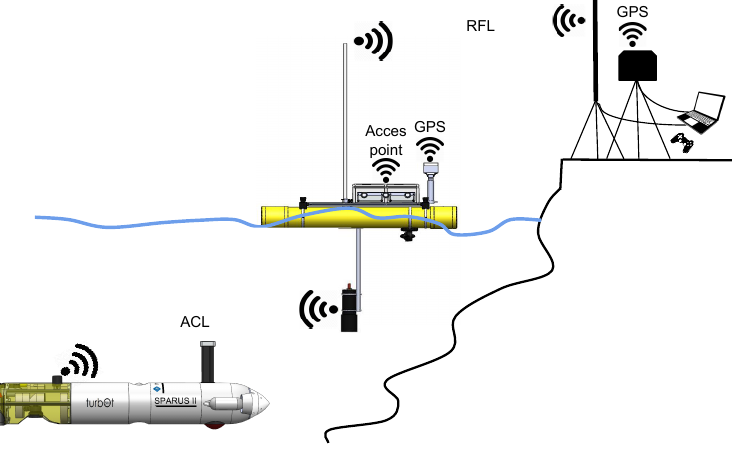
Figure 3. Communication